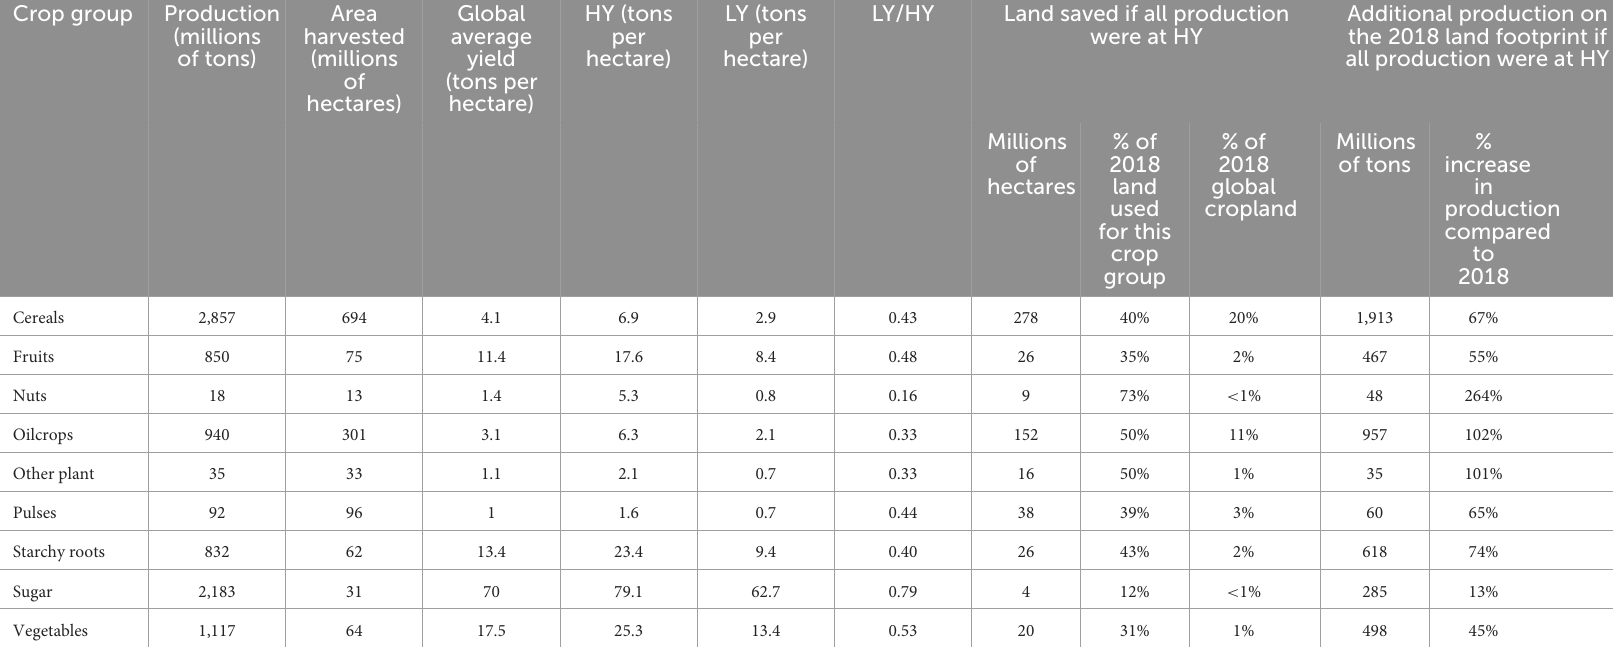
TABLE 3 Aggregated results by crop group for production, area harvested, yield and outcomes if HY were achieved for all crops globally. Crop